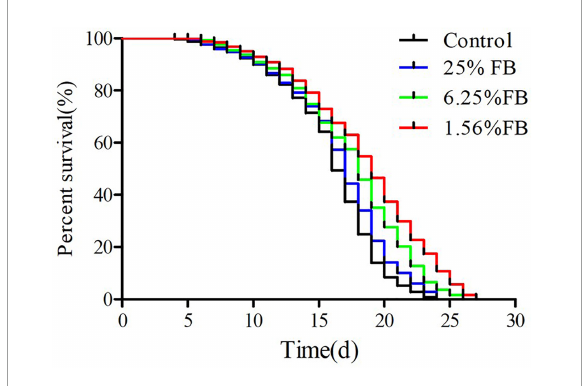
FIGURE7 The effects of FB on the lifespan of C. elegans .